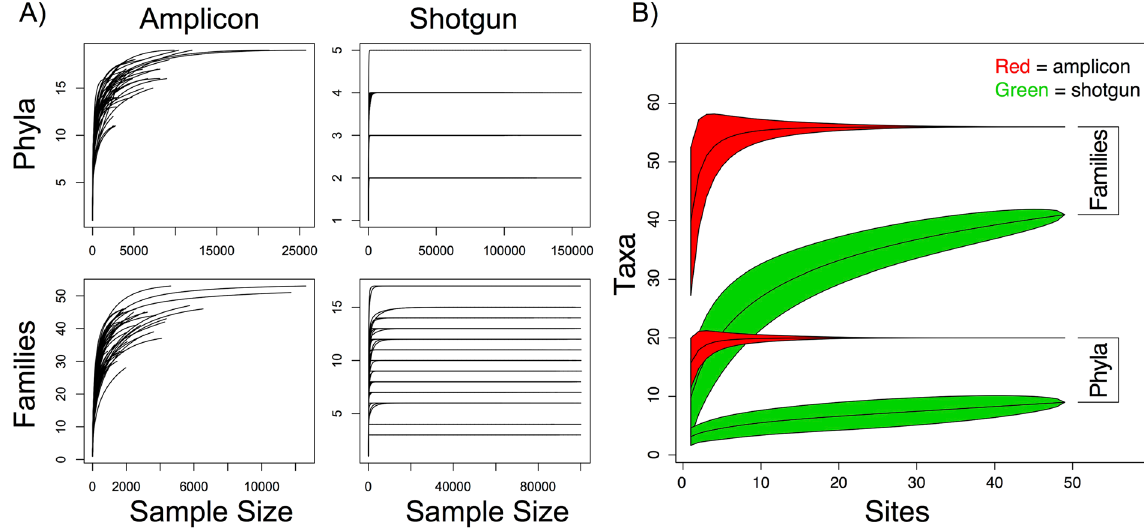
Figure 7. Comparisons of the sampling efforts for amplicon and shotgun sequence data at the phylum and family levels using ( A ) rarefaction curves for individual sites and ( B ) species accumulation curves for the 49 total sampling sites in